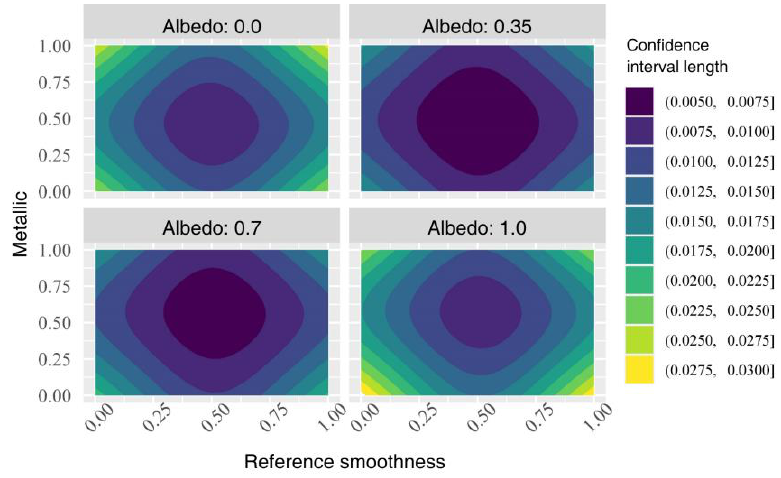
Figure 8. The results of differential distribution.